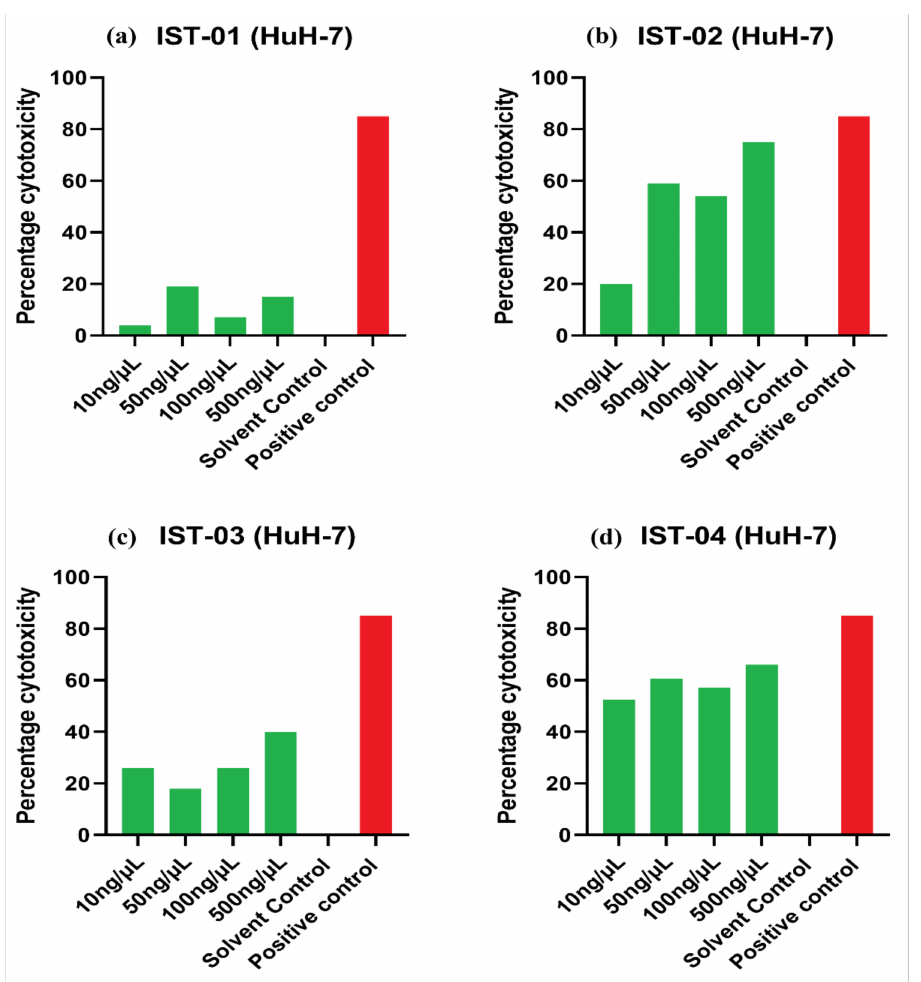
Figure 14. Percentage cytotoxicity of compounds: ( a ) IST-01, ( b ) IST-02, ( c ) IST-03, and ( d ) IST-04 on HuH-7 cells. PBS with 10% DMSO was used as the solvent control and Doxorubicin HCL was used as the positive reference control. Table 5. Percentage cytotoxicity and IC 50 value, along with standard deviation (SD), of the com- pounds IST-02 and IST-04 on HuH-7 and